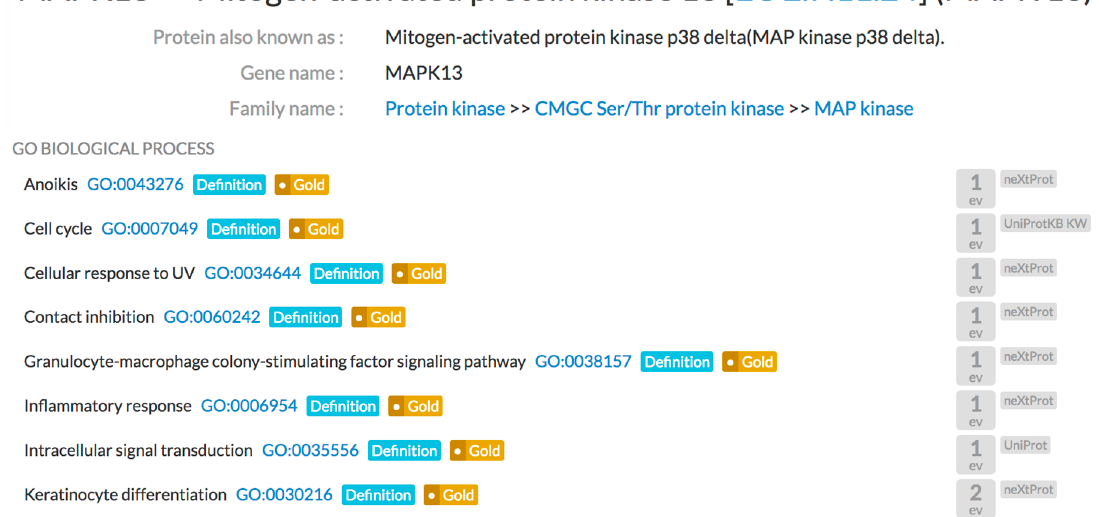
Figure 1 . The neXtProt function page for MAPK13 (https://www.nextprot.org/entry/NX_O15264/). Figure 1. The neXtProt function page for MAPK13